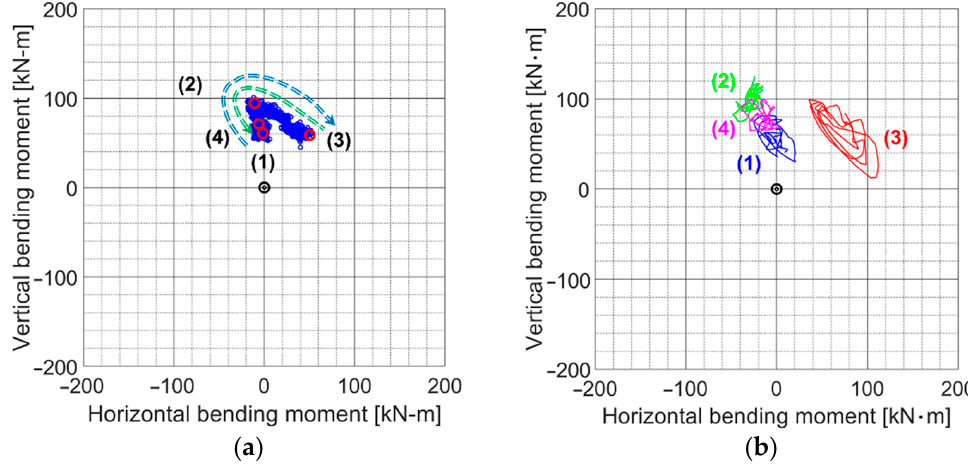
Figure 12. Trajectory plot of bending moment during rapid starboard turn. ( a ) Nominal bending moment; ( b ) True dynamic bending moment (orbit plot).